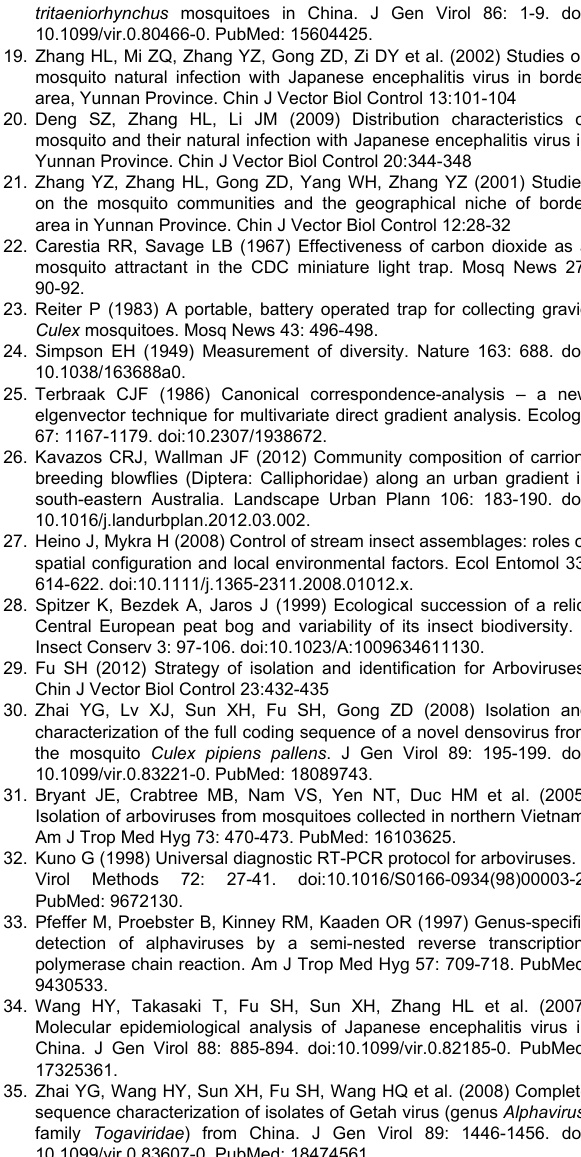
Table S2. The results of t-test for comparing SDI between Mangshi and Ruili.